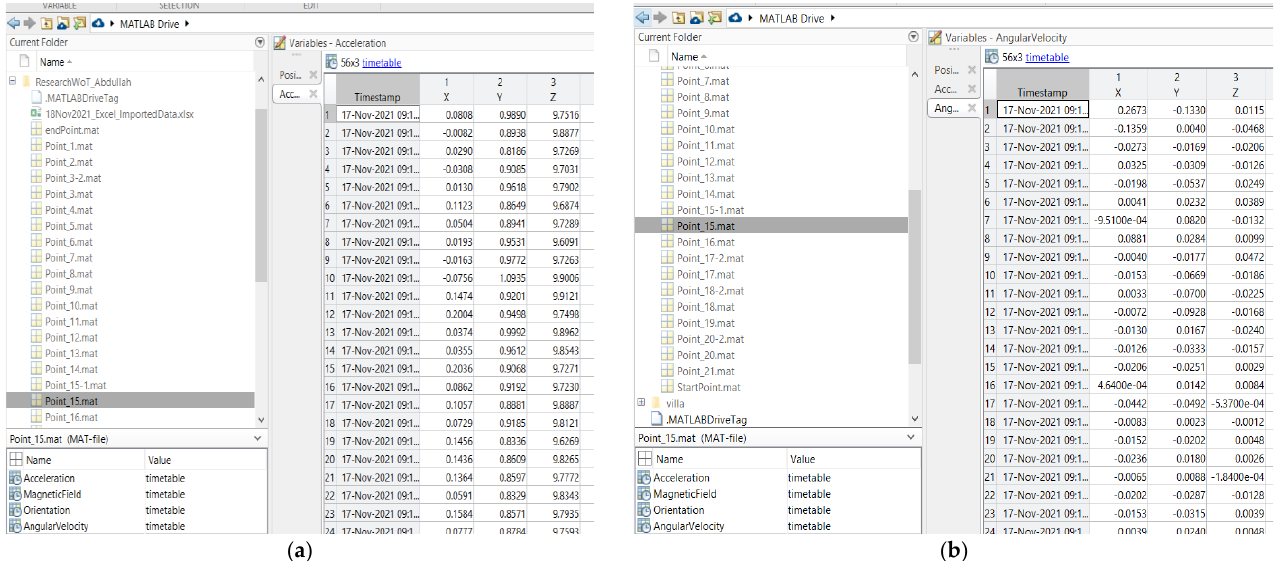
33 of 53 Figure 32. Length and heading to point_20. Figure 33. Length and heading to the end point.